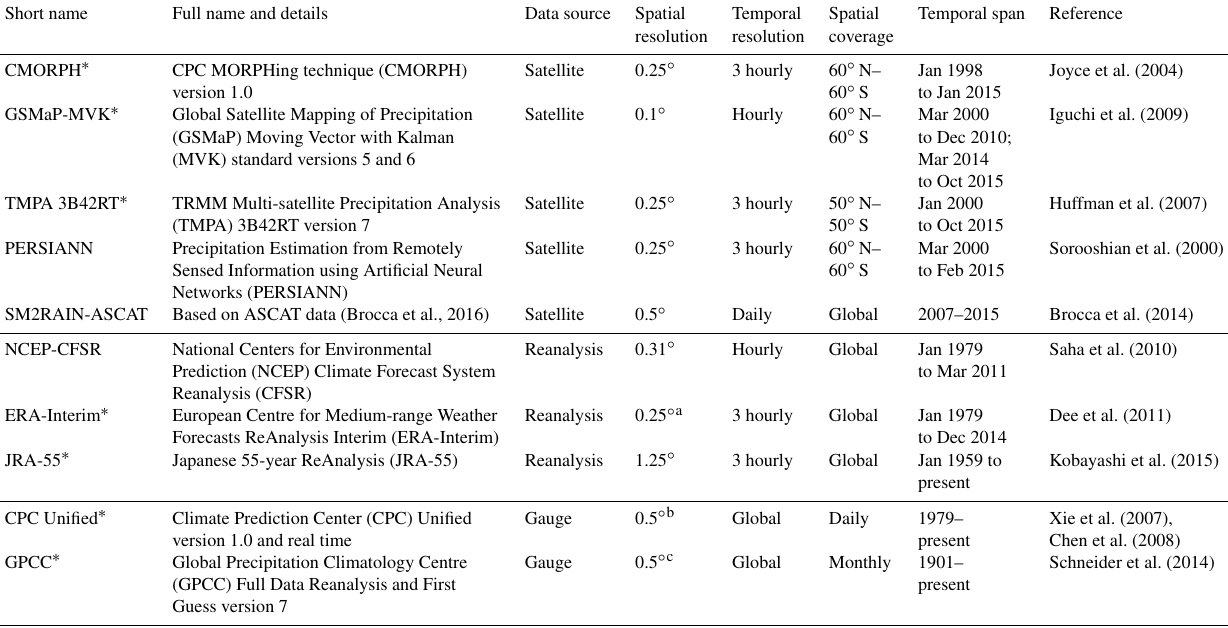
Table 2. Overview of the (quasi-)global P datasets considered for inclusion in